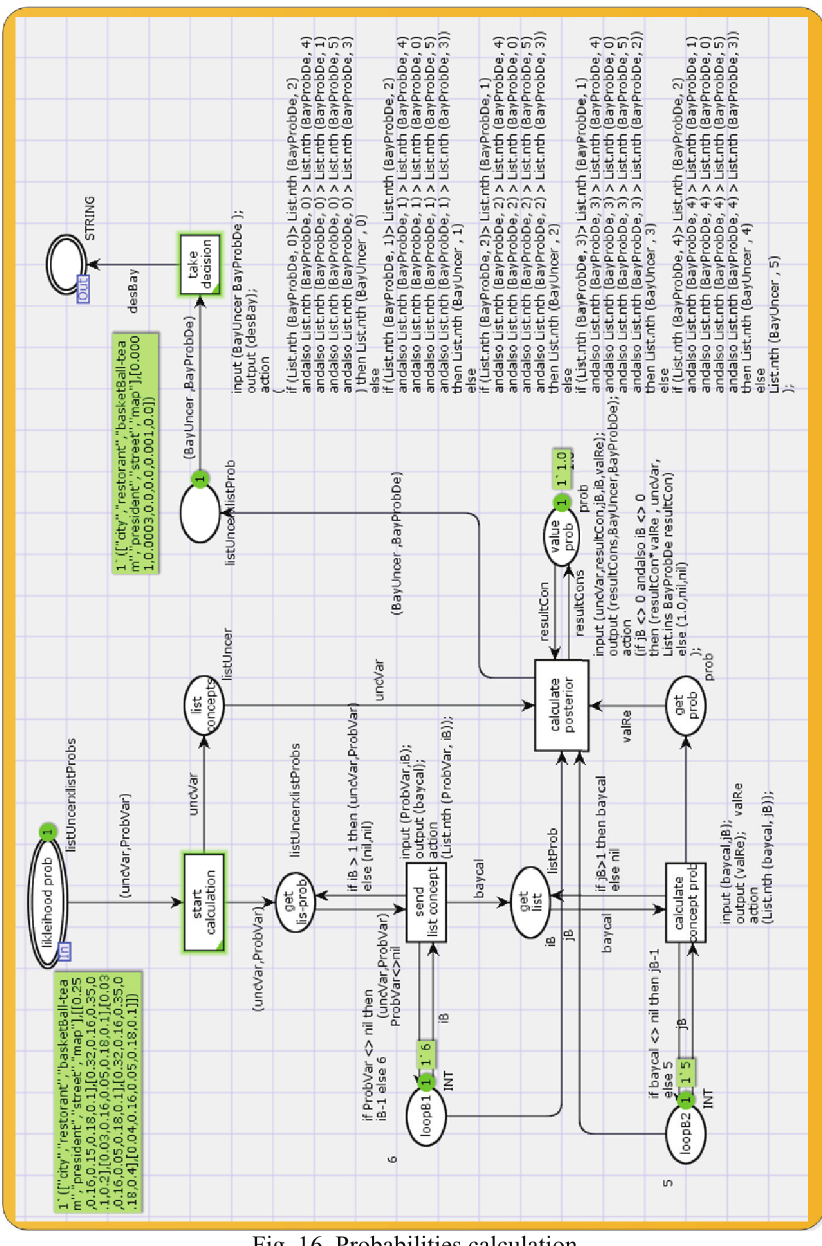
Fig. 16. Probabilities